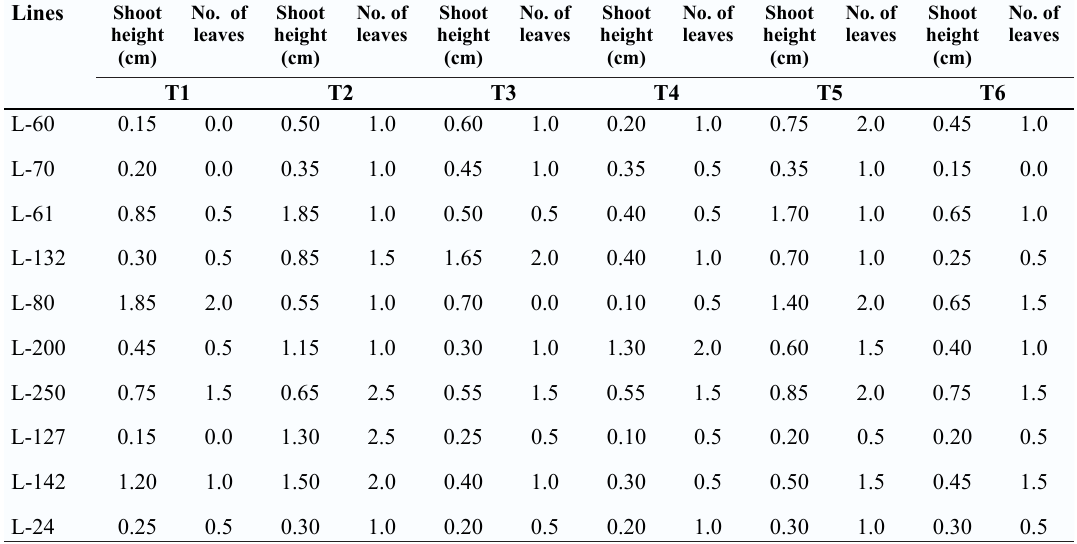
Table 1 . Evaluation of morphological parameters of 10 thorny artichoke lines in different treatments of growth regulators and type of agar in the initial stage.